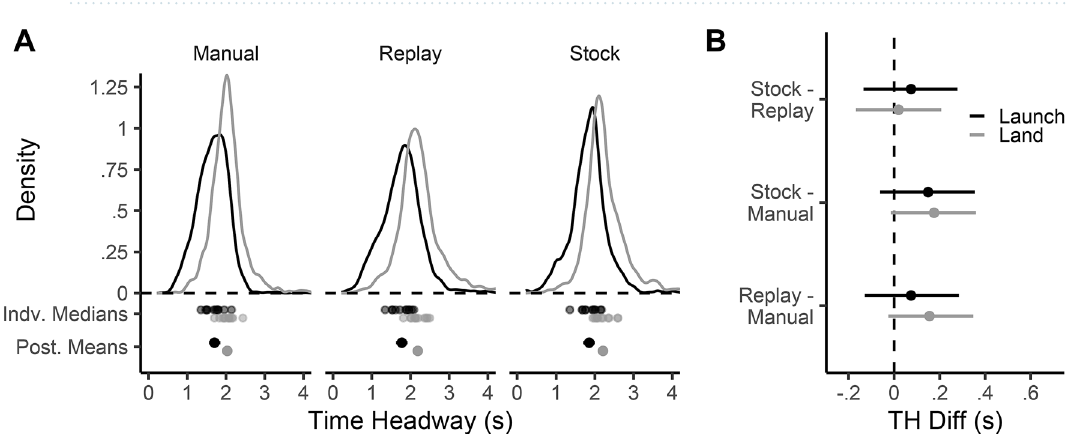
Figure 10. Saccade launch and land time headways. ( A ) The pooled empirical distribution of gaze Launch (black) and Land (grey) Time Headways (TH) for each driving mode. Also shown are the participant medians, and the posterior estimates of the mean of medians with 95% HDIs. ( B ) The Posterior estimate of the mean TH difference between conditions, with 95% HDIs shown, for saccade launch-points (black) and saccade land- points